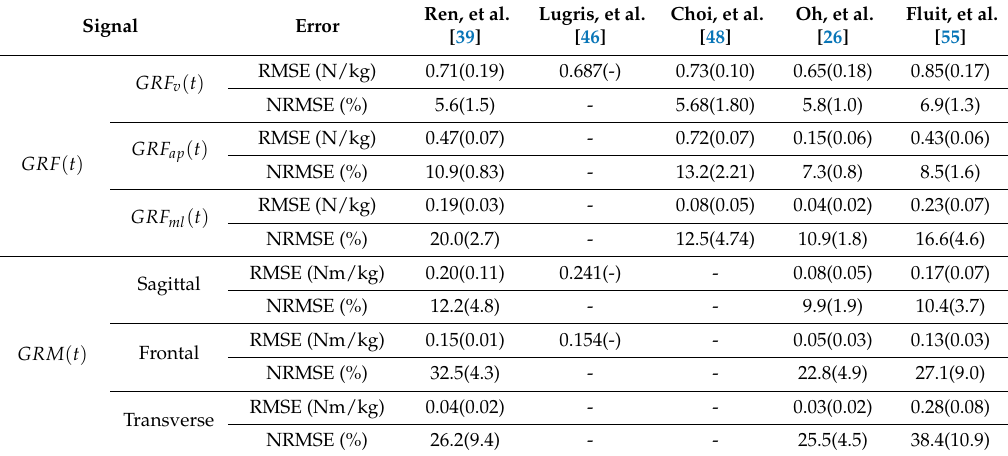
Table 1. Comparison of the mean (standard deviation) of RMSE for the methods suggested by Ren, et al. [39], Lugris, et al. [46], Choi, et al. [48], Oh, et al. [26] and Fluit, et al.